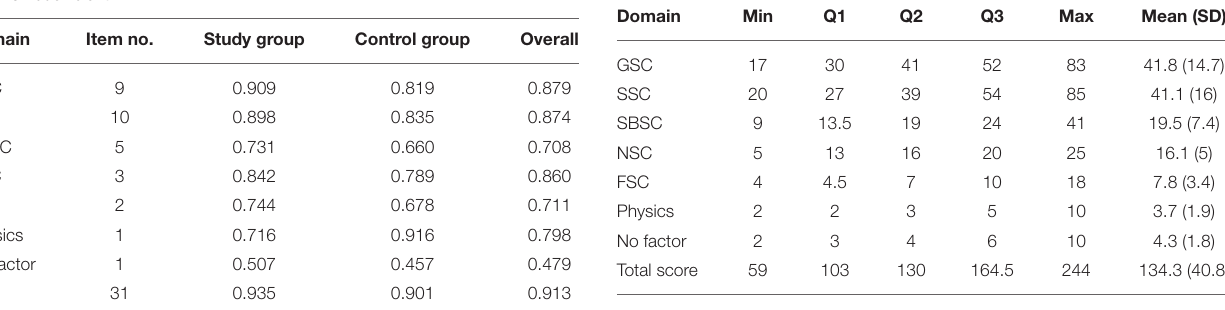
TABLE 3 | Spearman’s correlation coefficient between domains of Chinese DAS 59. Domain